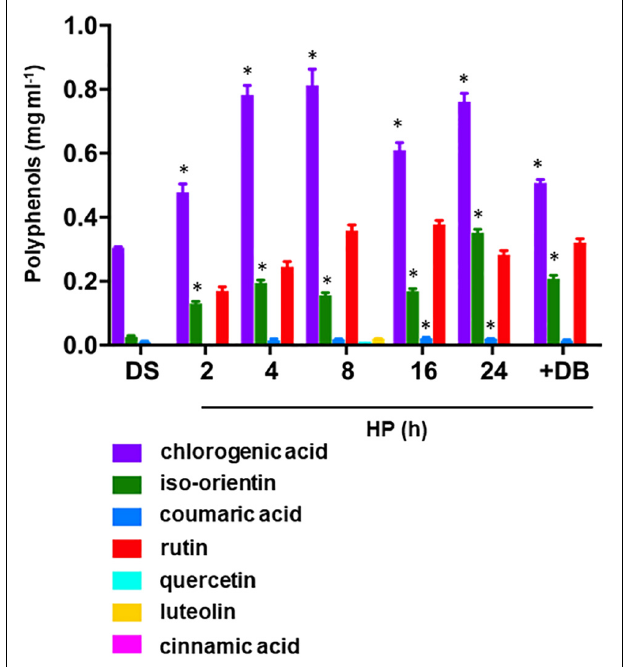
FIGURE 3 | Accumulation of phenolic compounds occurring in S. villosum seeds during hydropriming as well as at the end of dry-back. Values are expressed as mean ± SD of three independent replicates with 15 seeds for each replicate. Asterisks indicate statistically significant differences determined using Student’s t -test ( P < 0.01). DB, dry-back; DS, dry seed; FW, fresh weight; HP, hydropriming; RD, radicle protrusion; UP,